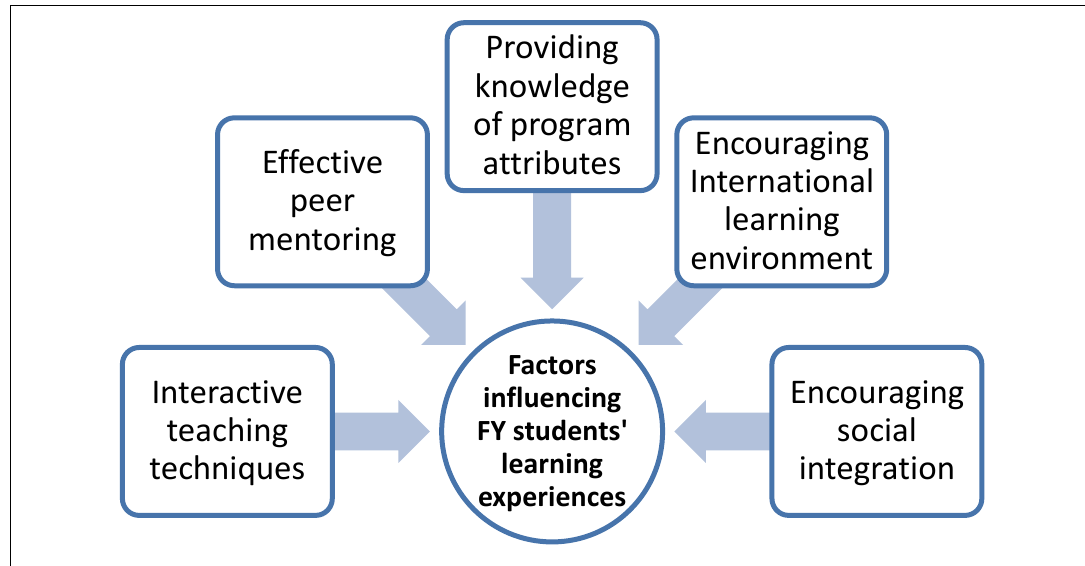
Figure 5. Factors influencing FY students' learning